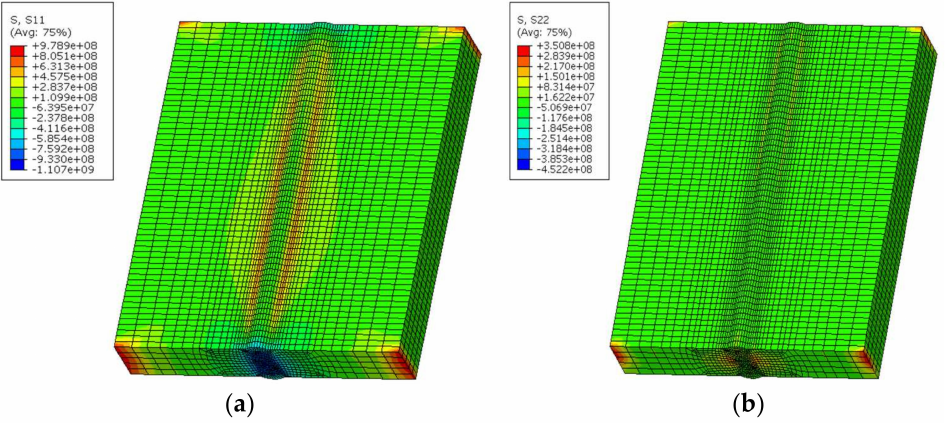
Figure 7. Residual stress distribution in Model I: ( a ) transverse residual stress; ( b ) longitudinal residual stress.